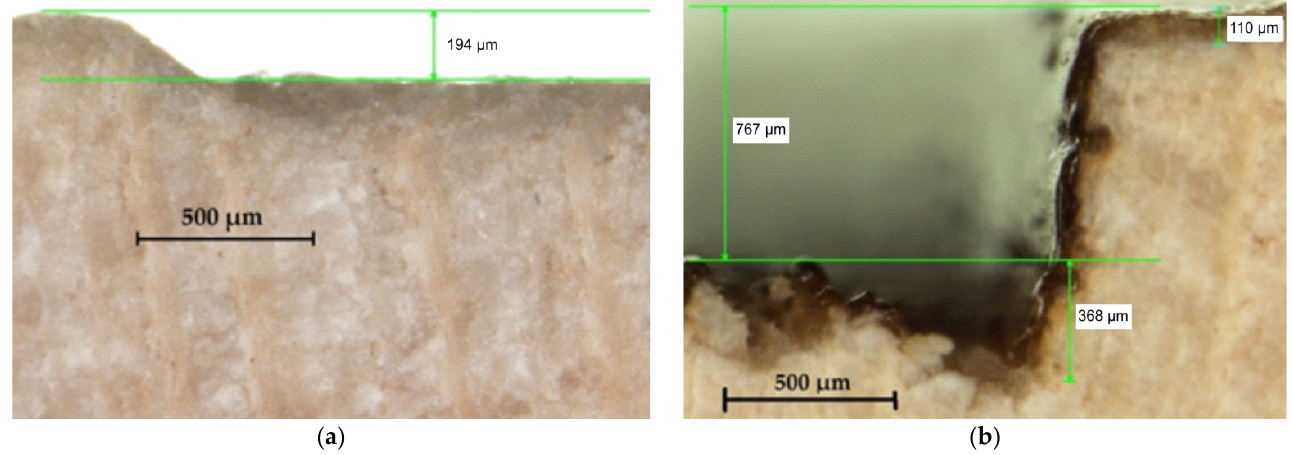
Figure 13. Measured wood burning depth for laser engraved surfaces (90× magnification): ( a ) With power of 10% of the maximum laser beam power of 150 W; ( b ) With power of 40% of the maximum laser beam power of 150 W.